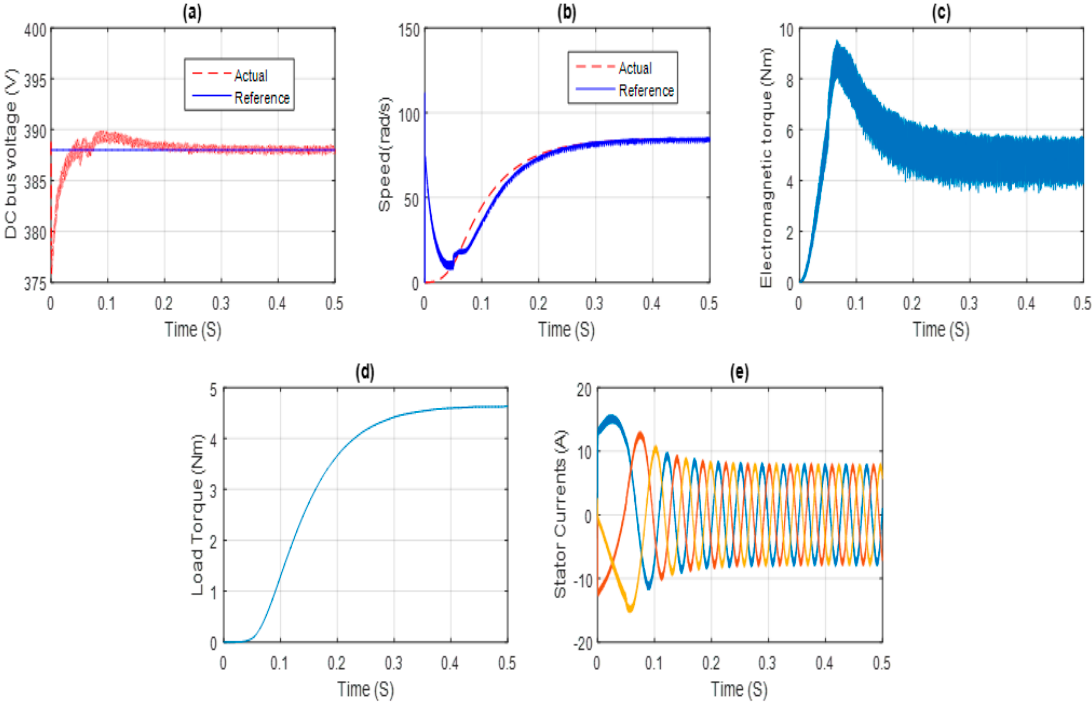
Figure 10. The detailed performance of SPVWP system under first scenario using P&O based tracker.